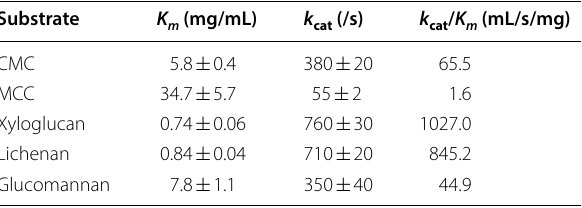
(Additional file 1: Table S2). These results indicate that the specific activities of FsXEG12A towards the sub- strates are at least equal to those of other GH12 XEGs Table 3 Apparent kinetic parameters of the purified with broad substrate specificity (Segato et al. 2017; FsXEG12A toward the various polysaccharides Yang et al. 2017). FsXEG12A degrades both xyloglucan and cellulose, resulting in weakening of the cellulose– xyloglucan network. This allows the fungus to infect the plants and utilize the reaction products of cellulose and xyloglucan for fungal growth. Therefore, the broad substrate specificity of FsXEG12A from Fusarium spp. strain EI is beneficial for degrading the complex wood components such as cellulose, xyloglucan, galacto- Data are mean standard deviation of three experiments. Recombinant ± glucomannan, and xylan, which compose 30–40%, FsXEG12A (1.0 μM) was incubated with substrates in 50 mM acetate buffer